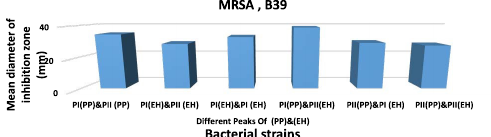
Fig. 7. The antimicrobial activity of a mixture of peak I and peak II for both extracts P . plebeium (PP) & E. hirta ( EH) against MRSA